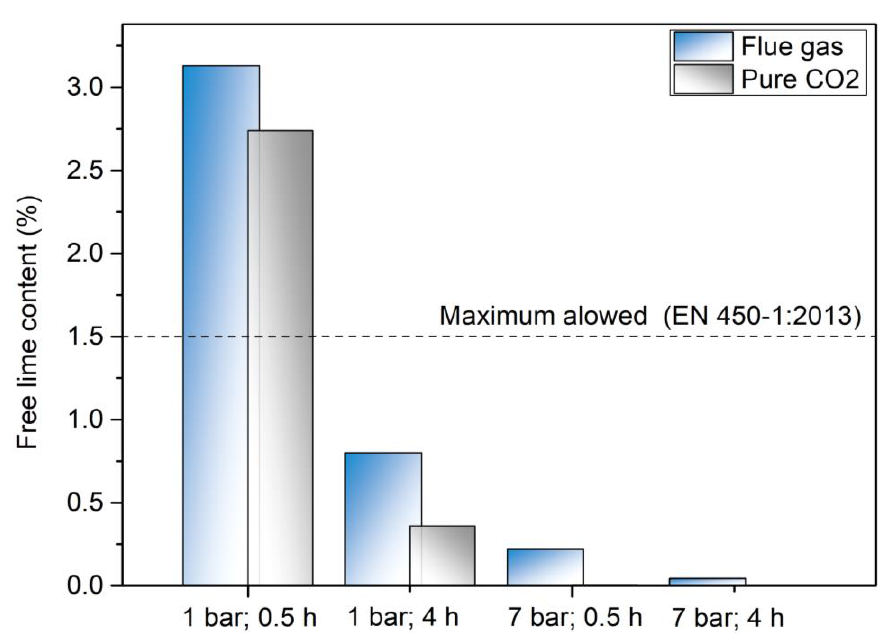
Figure 6. Free lime determination results for carbonates fly ash samples. The dashed line indicates the maximum free lime content allowed by EN 450-1:2013.